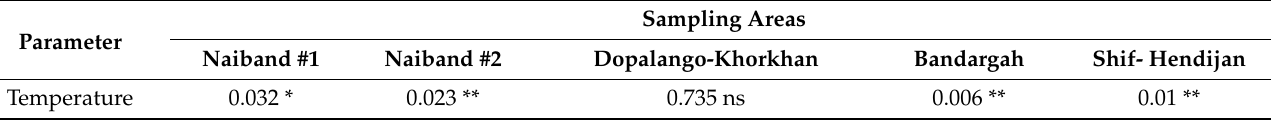
Table 3. The t -test results of temperature between SGD and non-SGD